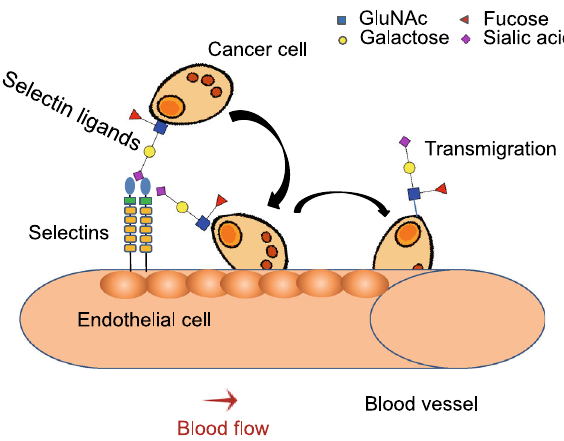
Figure 5. The role of selectin-ligand binding in tumor metastasis. Activated endothelium secrets selectins, which mediate cancer cell rolling on the endothelium. Finally, the cancer cell migrates through the endothelium to other parts of the